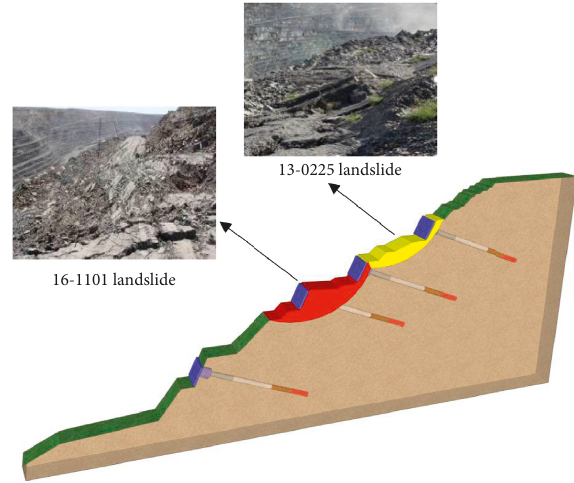
Figure 14: Characteristics of the “16-1101 landslide.”